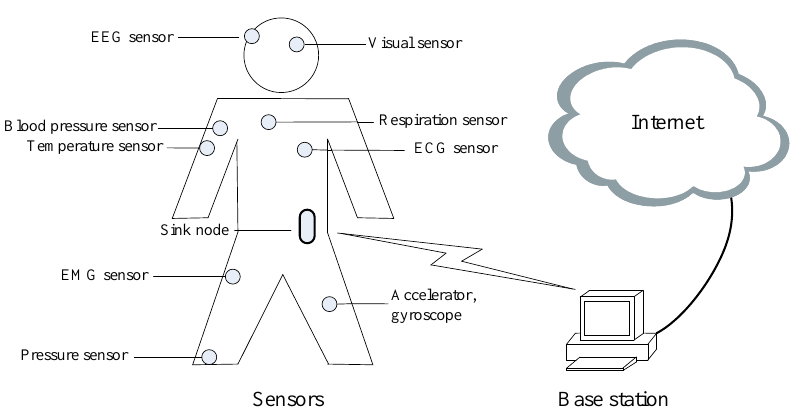
Figure 1. Architecture of a BSN.